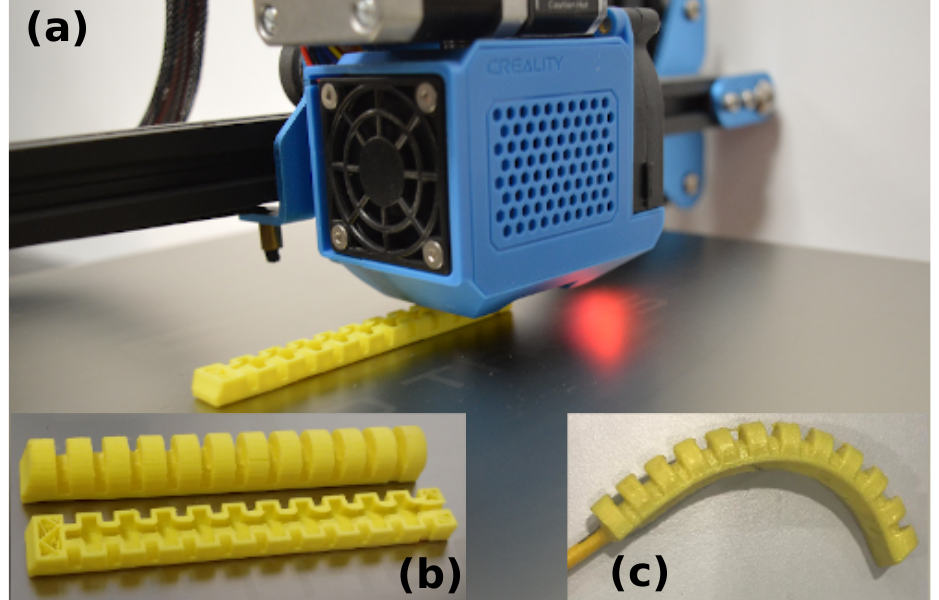
Figure 4. ( a ) Printing the soft actuator using a Creality CR-10 3D printer, ( b ) the 3D printed device and a section of partially printed soft actuator using TPU material, and ( c ) the actuated soft actuator with an internal pressure.